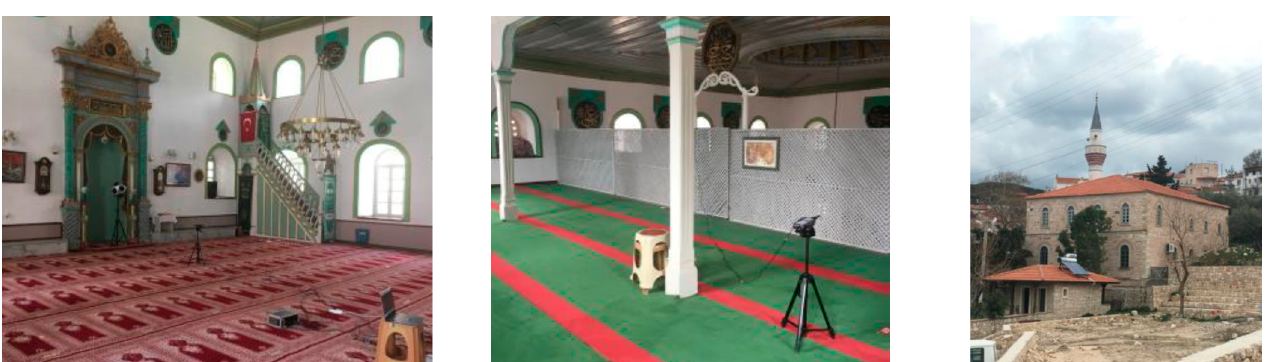
Figure 6. Main and women’s prayer hall of E ğ lenhoca Mosque (photos by the authors).